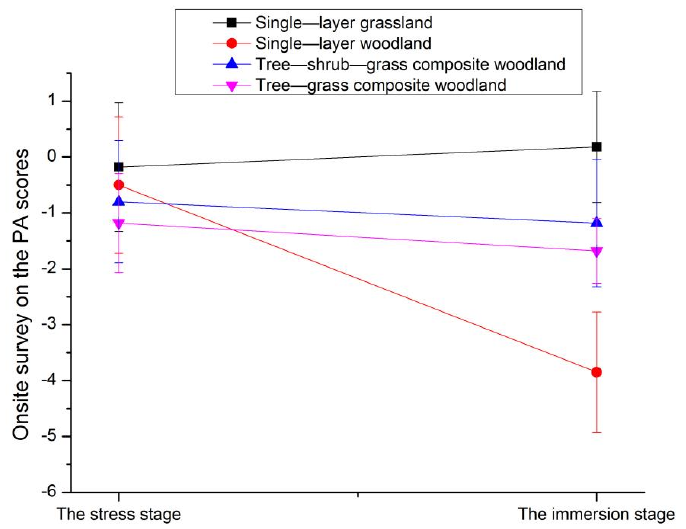
Figure 7. Effect of onsite surveys on participant PA scores.